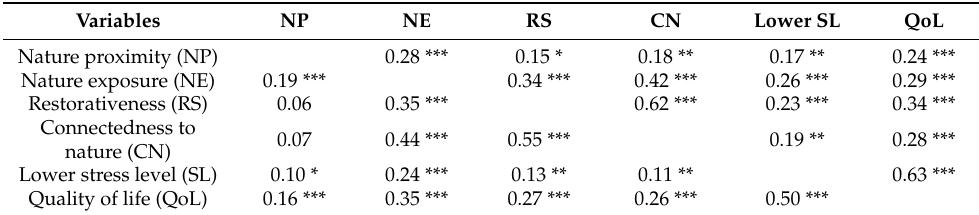
Table 2. Correlations between study variables (n = 924).